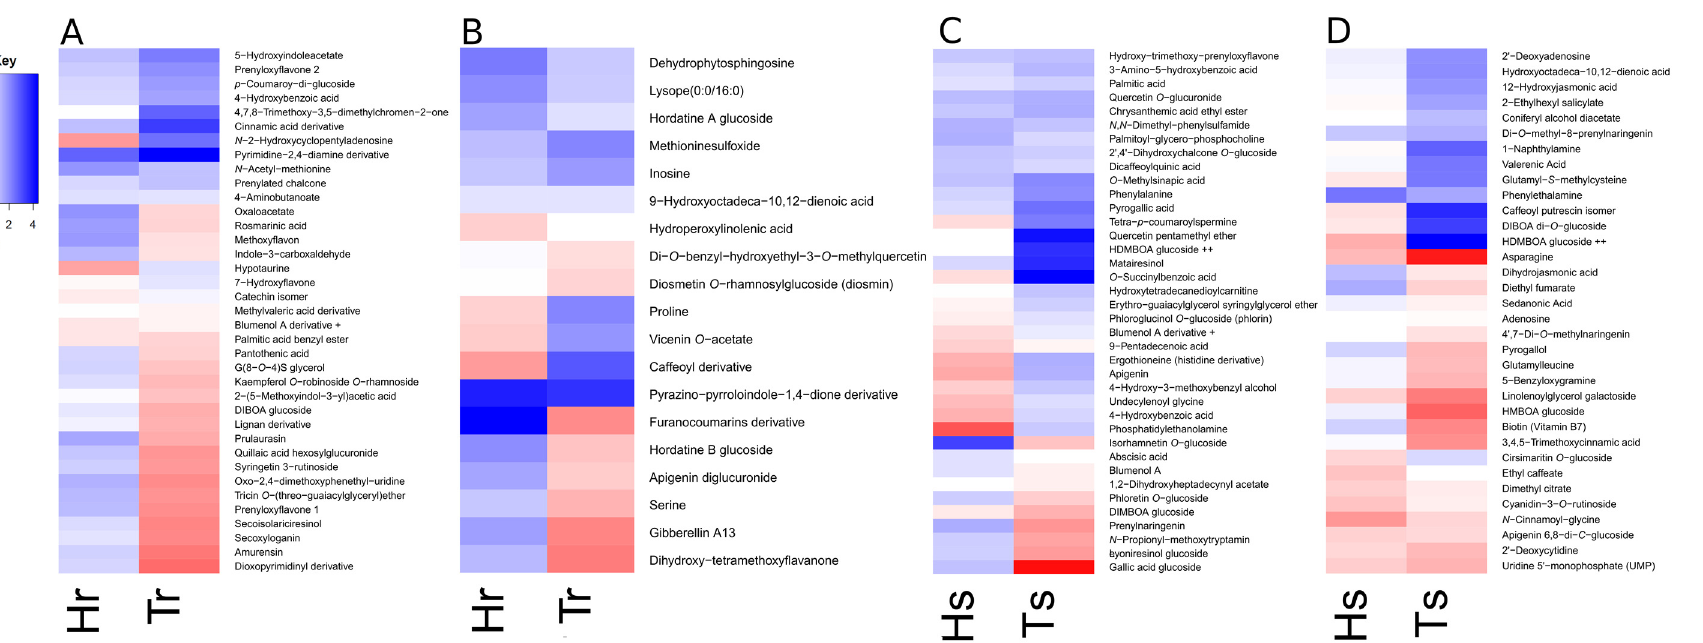
Figure 4. Differences in accumulation of selected DAMs shared for FHB-resistant Hr and Tr genotypes: ( A ) at T1 time point, ( B ) at T2 time point or FHB-susceptible Hs and Ts genotypes ( C ) at T1 time point and ( D ) at T2 time point. Details of annotation are available in Table S6. Symbol ”Hs” is for Hordeum vulgare FHB- susceptible genotype, “Hr” is for Hordeum vulgare FHB-resistant genotype, “Ts” is for Triticum aestivum FHB-susceptible genotype and “Tr” is for Triticum aestivum FHB-resistant genotype. The color key refers to differences in abundance (shown in log 2 scale) between infected and control plants. The rows were initially sorted in a descending order, first by Hr and Hs, respectively, then by Tr and Ts, and then secondly reordered based on row means. The symbols “+” and “++” represent two the same metabolites present at different treatment types and time points.